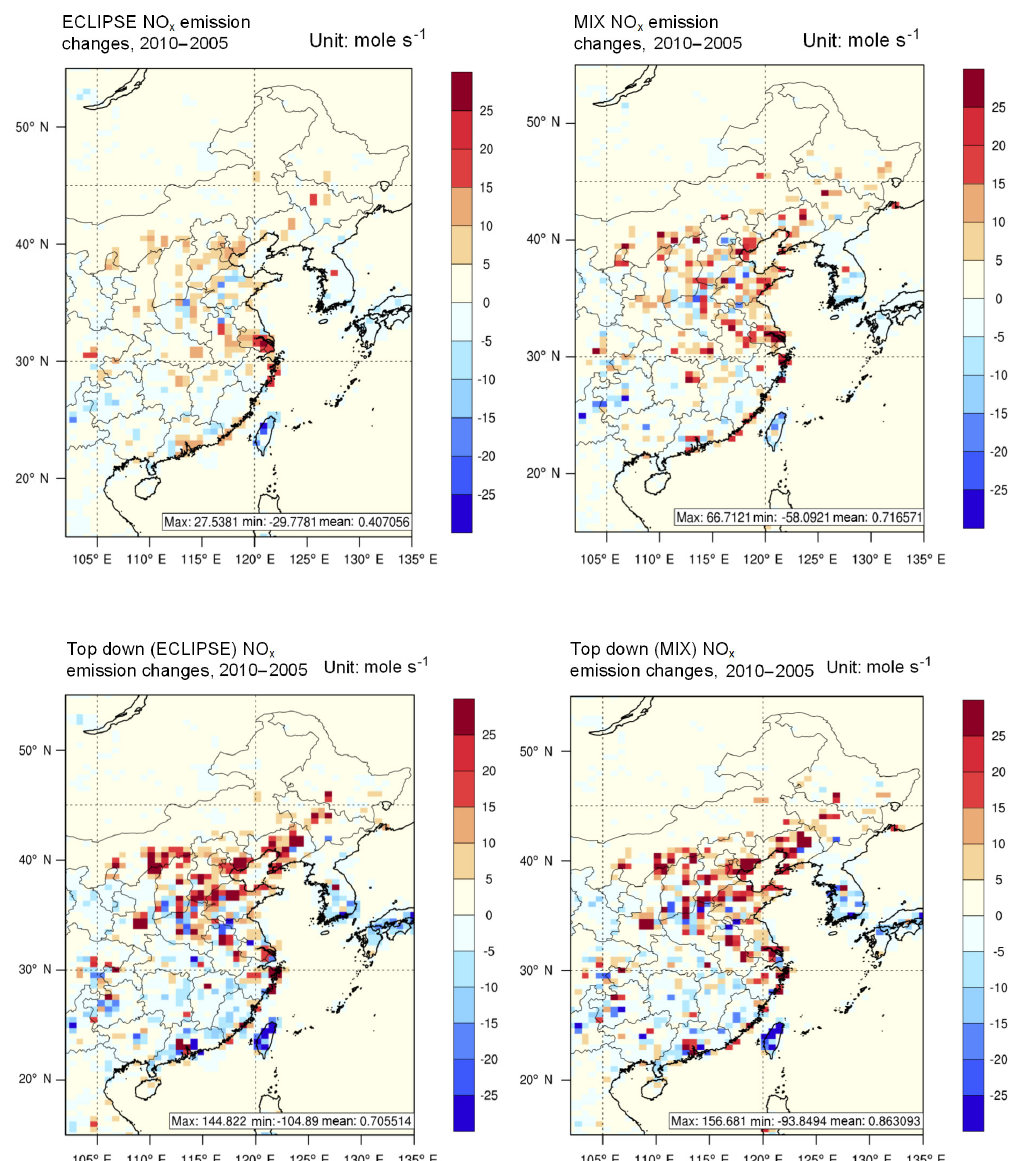
Figure 11. NO x emission changes from 2005 to 2010, estimated by ECLIPSE, MIX and derived top-down inventories for each case; summer average